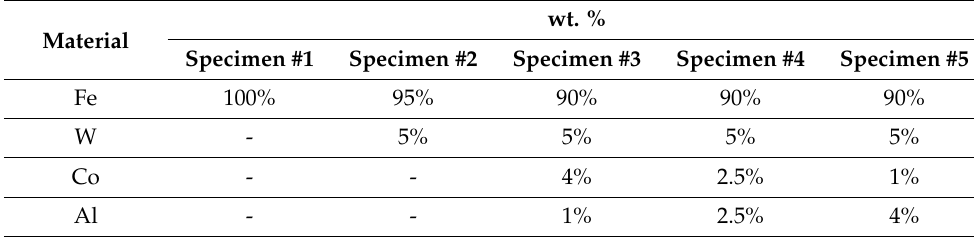
Table 1. Chemical composition of the prepared